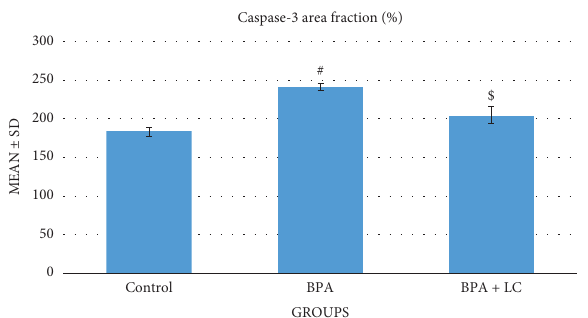
Figure 8: Graph demonstrating the quantitative analysis of caspase-3 expression area percentage of the heart. Data are expressed as means ± SDs. # : signifcantly diferent from the control group, while $ signifcantly diferent from the BPA group ( P < 0 .